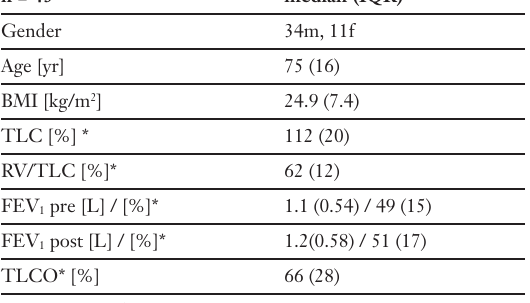
Baseline characteris- tics, patients with known COPD.